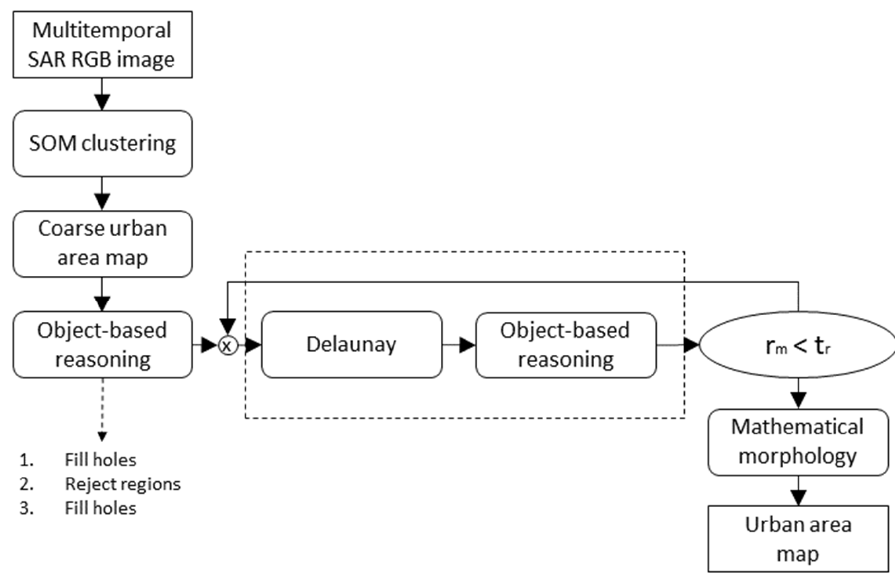
Figure 1. Block diagram of the proposed technique. Blocks with rounded corners indicate processing blocks. Rectangles stand for the products.